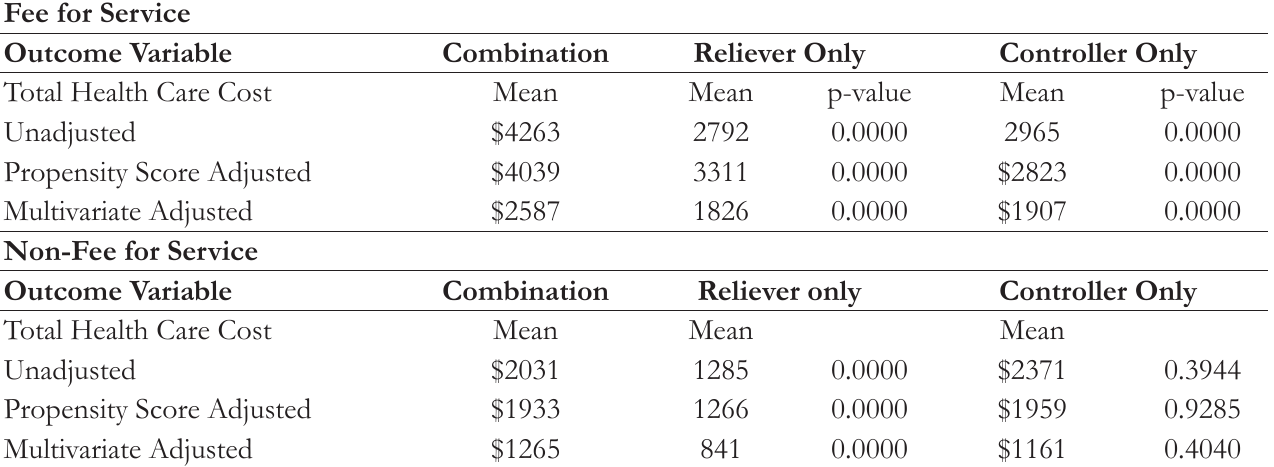
Table 3. Analysis of Outcome